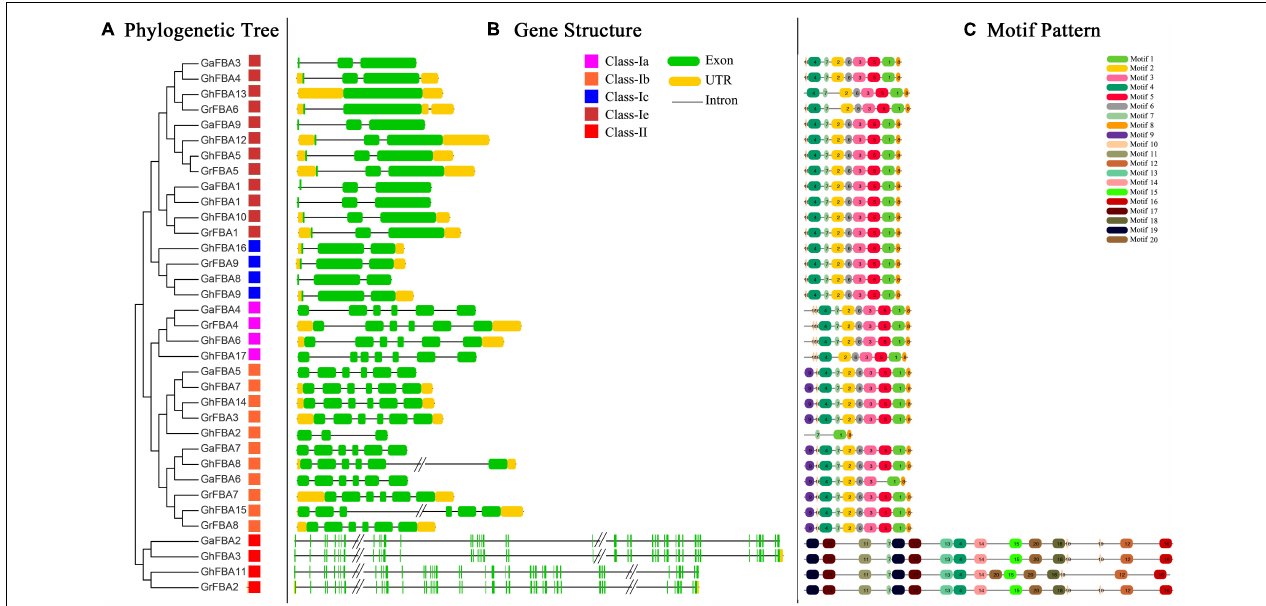
FIGURE 3 | Phylogenetic relationships, gene structure and architecture of conserved protein motifs in FBA genes from G. hirsutum (Gh) , G. arboreum (Ga) and G. raimondii (Gr). (A) The phylogenetic tree of all identified cotton FBA genes. Full-length protein sequences of FBA genes were used to generate the phylogenetic tree, and the different color squares represent phylogenetic subclasses. (B) Gene structure features of cotton FBA genes. Green boxes indicate exons, black lines indicate introns and yellow boxes indicate 3 (cid:48) and 5 (cid:48) untranslated regions. (C) The motif architecture of cotton FBA proteins.